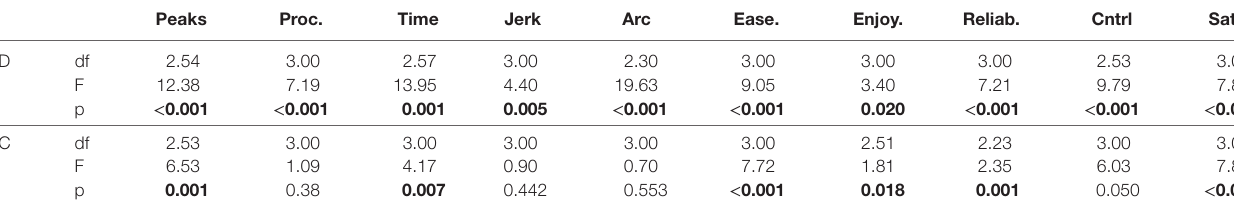
TaBle 2 | ANOVA results for contour­following task (C) and drawing task (D), df, F, and p are the ANOVA parameters. Peaks Proc.